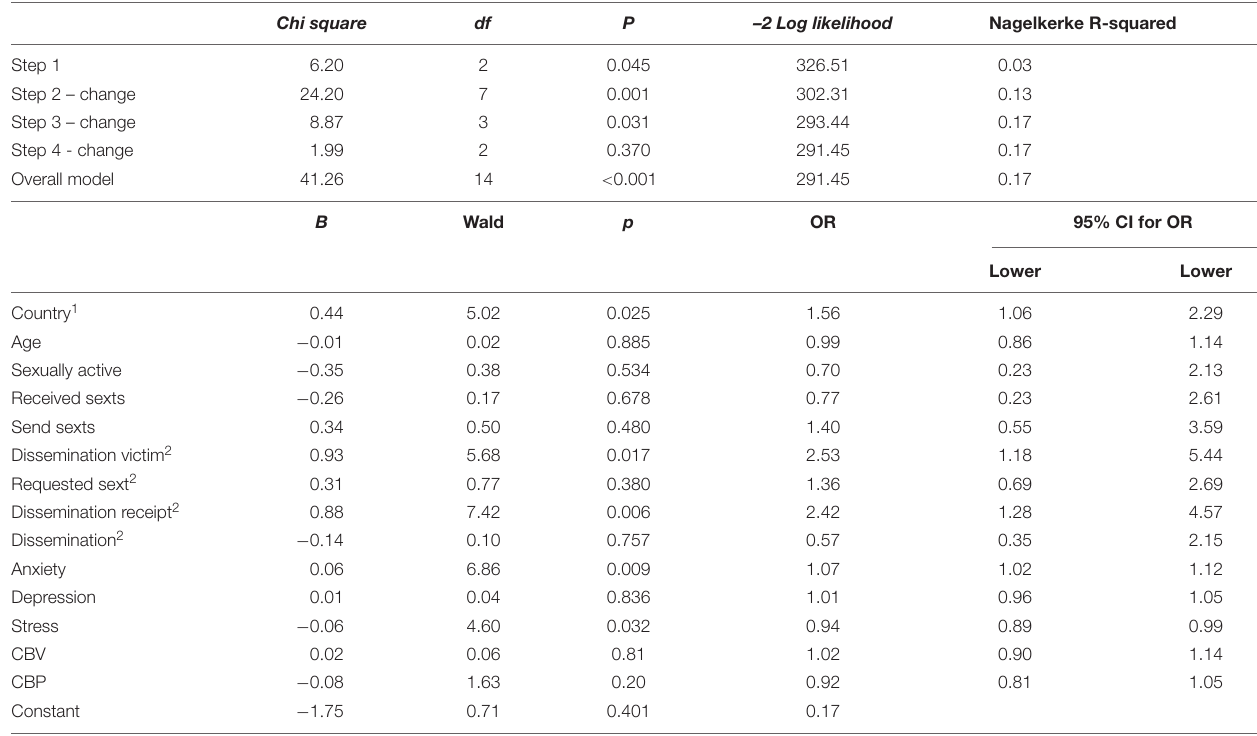
TABLE 6 | Regression results – predictors of visiting OIBEV site visitation for